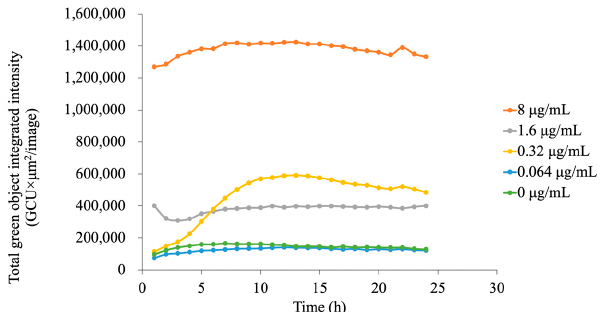
Figure 7. Assessment of apoptosis in the kinetics experiment. Apoptosis induced by glucose-conjugated chlorin e6 (G-Ce6)-mediated photodynamic therapy was determined by an Annexin V-fluorescein isothiocyanate fluorescence study using a live-cell analysis system. The cells were incubated with various concentrations of G-Ce6 (0, 0.064, 0.32, 1.6, or 8.0 µ g / mL) for 24 h at 37 ◦ C. After washing with fresh media, the cells were irradiated with 650-nm laser light (10 mW / cm 2 ; 5 J / cm 2 ). The x-axis represents time (h), and the y-axis represents the total green object integrated intensity. Apoptosis was dependent on the concentration of G-Ce6. GCU, green calibrated